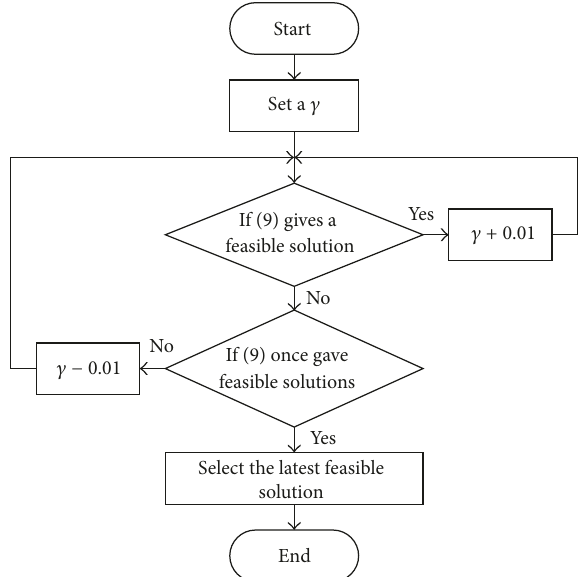
Figure 2: Flow chart of selecting the optimal inhibition rate.